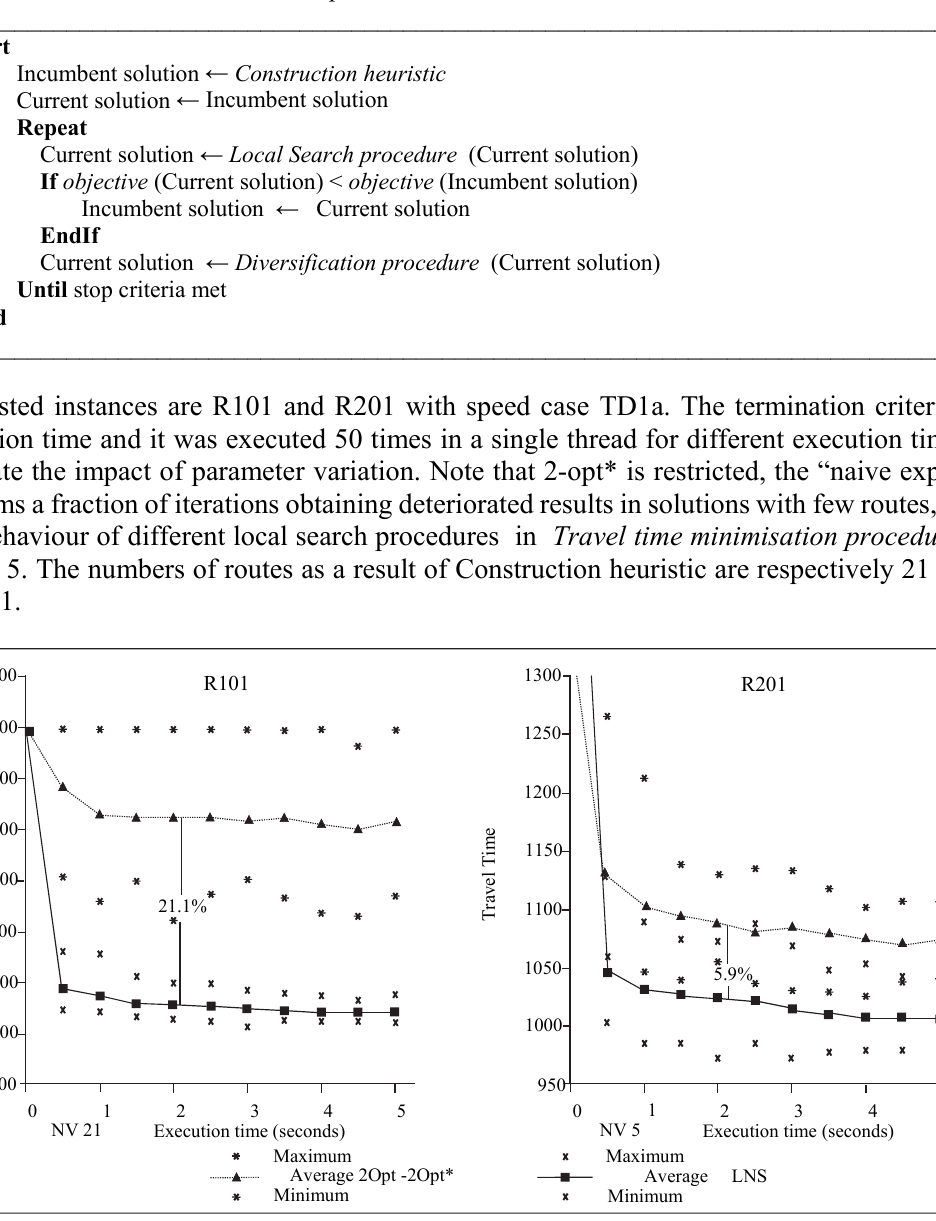
Algorithm 4: Travel time minimisation procedure 2